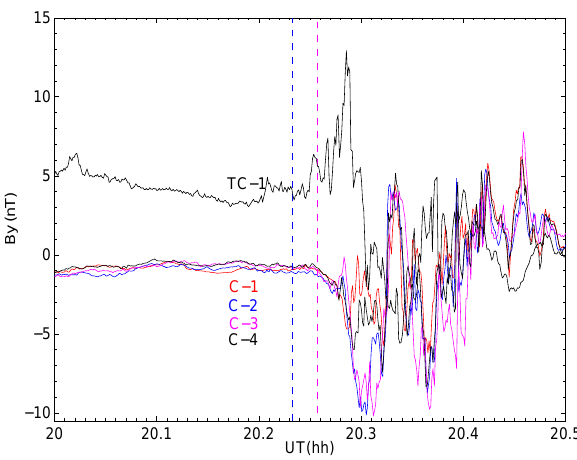
Fig. 7. TC-1 and Cluster observation of the B y components in GSM coordinates. The vertical dashed blue line denotes the sub- storm onset time and the dashed red line, 1.44min later, the time of field dipolarization at